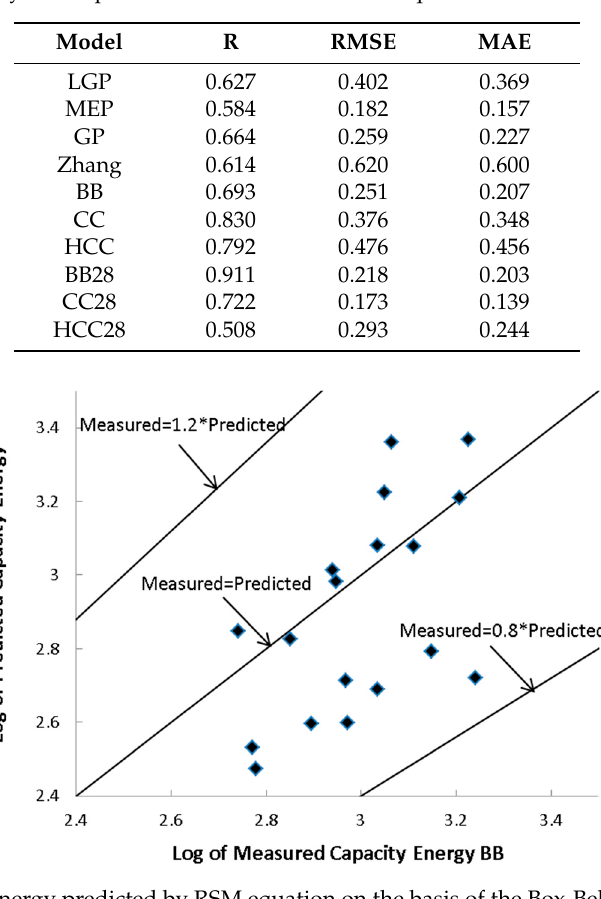
Table 14. Summary of comparison between six new RSM equations and four available models.